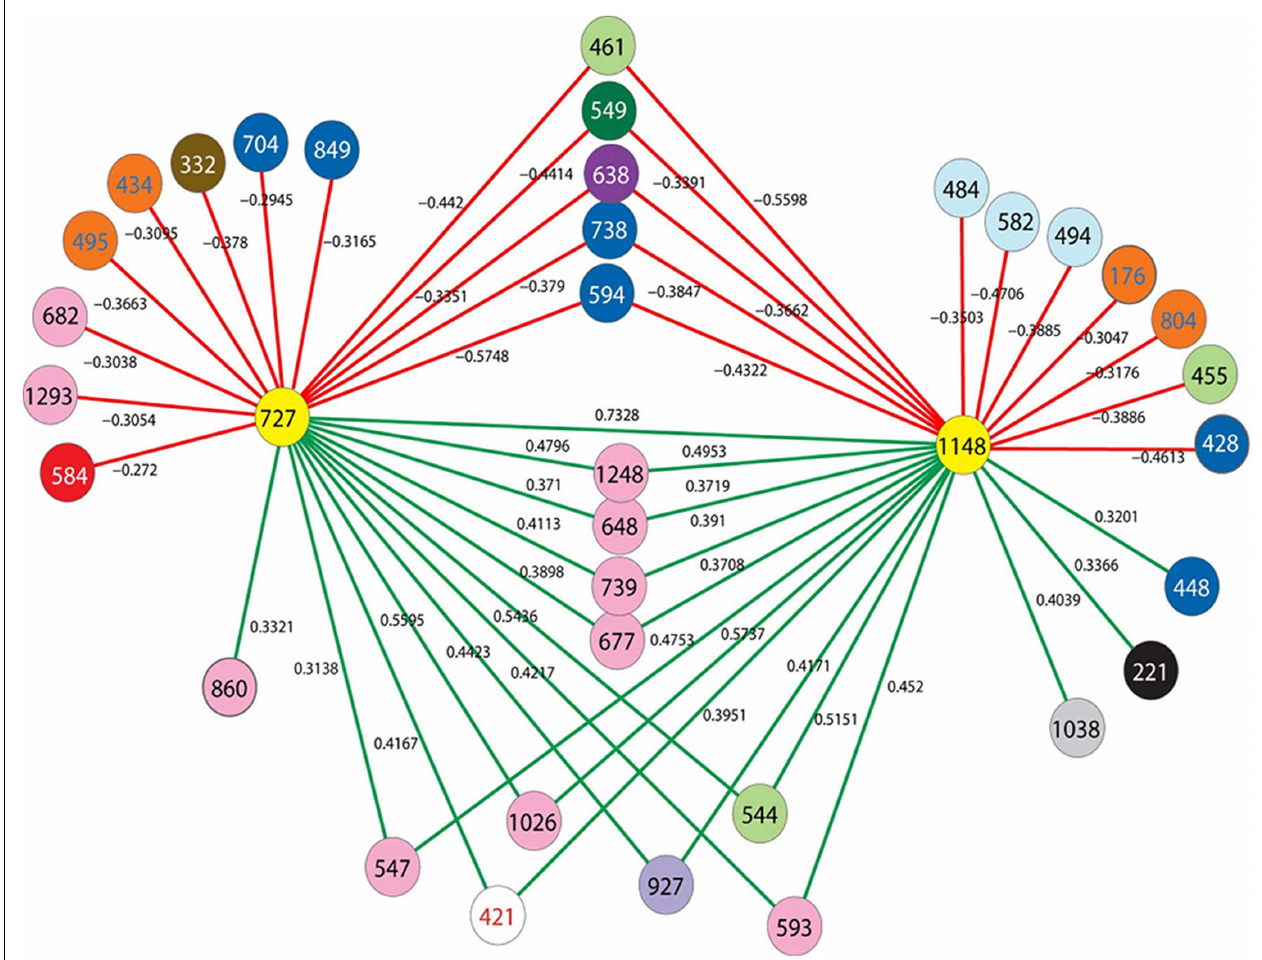
Euryarchaeota; red, unclassified Crenarchaeota; orange, Nanoarchaeota; purple, unclassified Desulfurococcales; lavender,Thermoplasmatales; light green, Archaeoglobaceae; light blue, Methanococcaceae; gray, Thermococcaceae; brown,Thermofilaceae; black, Pyrodictaceae; dark blue, Desulfurococcaceae; dark